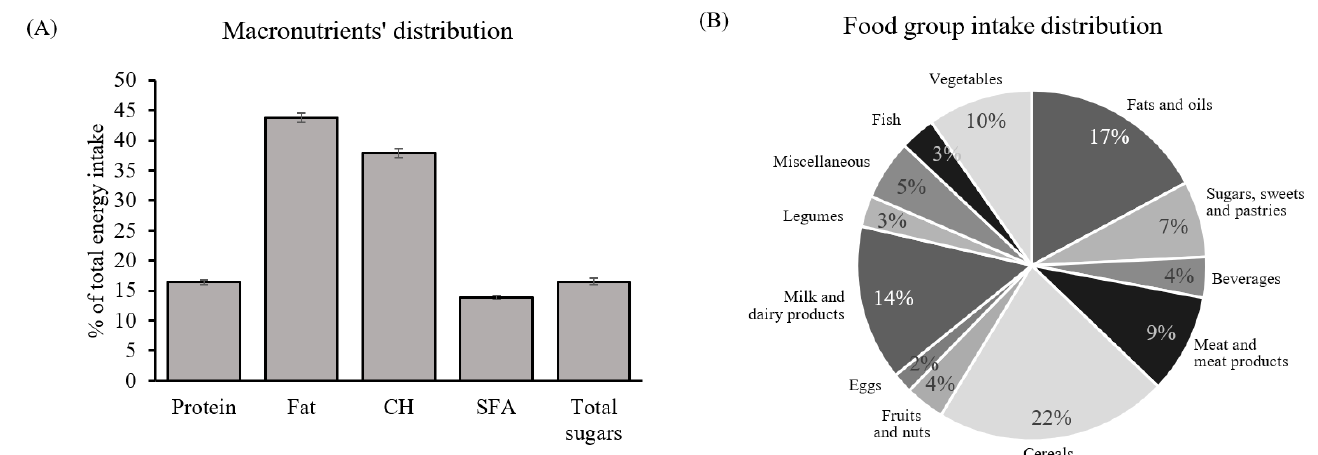
Figure 4. General dietary characterization of the cohort: ( A ) macronutrient distribution. Percentage of total energy intake coming from protein, fat, CH, SFA, and total sugars; ( B ) food groups. Percentage of total energy coming from twelve different food groups. Data are mean ± SEM ( n = 59). Abbreviations: SFA: saturated fatty acids; CH: carbohydrates.